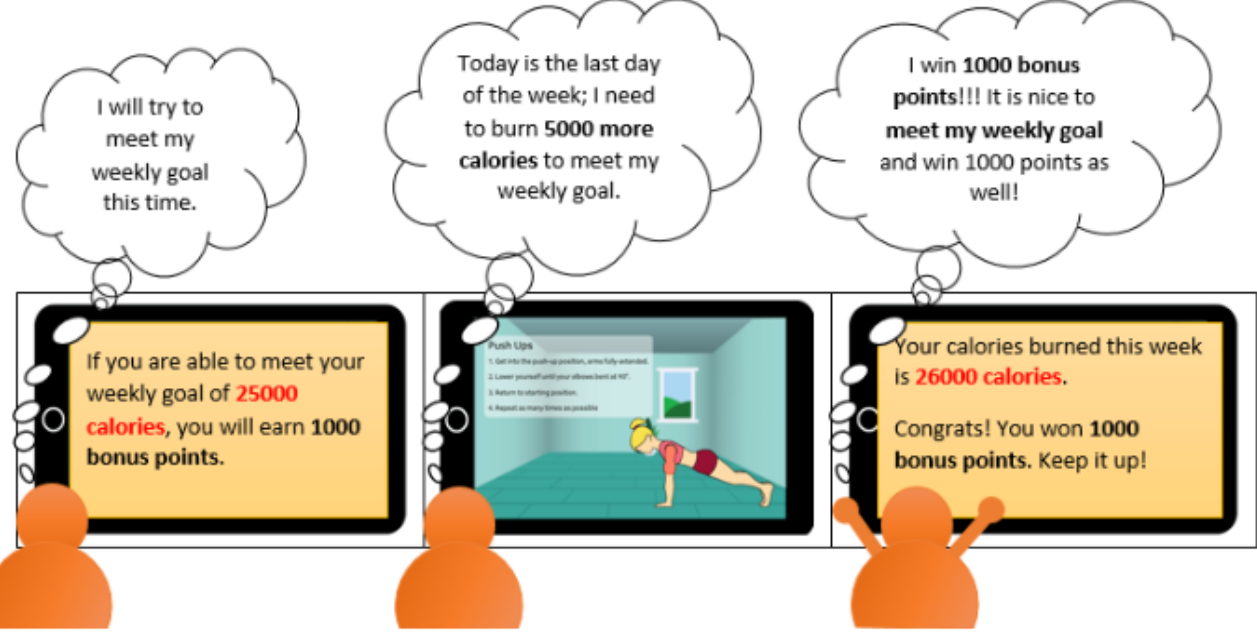
Figure A2. Low-fidelity storyboard illustrating the Reward feature of the fitness app [30].